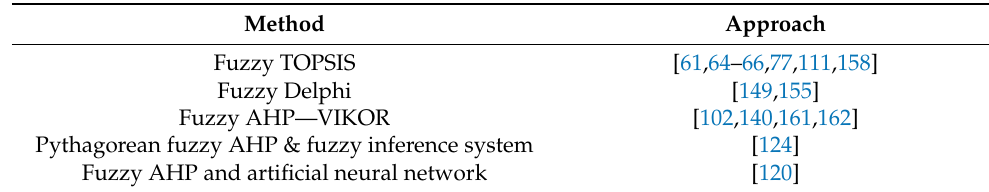
Table A8. Articles that hybridize and/or compare the fuzzy AHP methodology with other MCDM